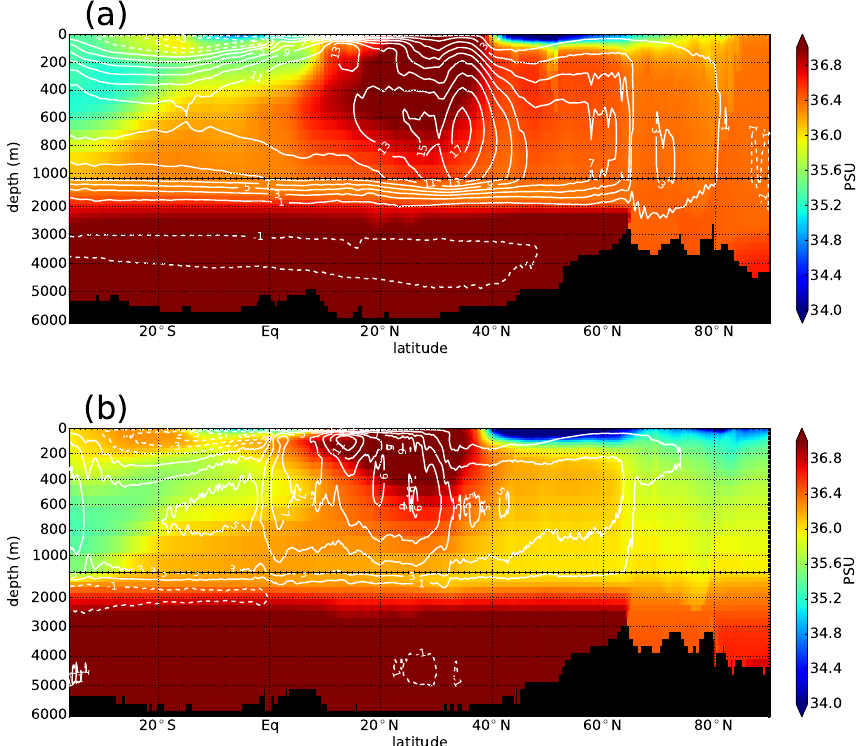
Fig. 7. Atlantic meridional overturning circulation (AMOC) computed for (a) the coarse resolution ORCA1 simulation and (b) the eddy- permitting ORCA025 simulation. Units in Sv=10 6 m 3 s − 1 . The time and zonally averaged salinity (PSU) are represented in the